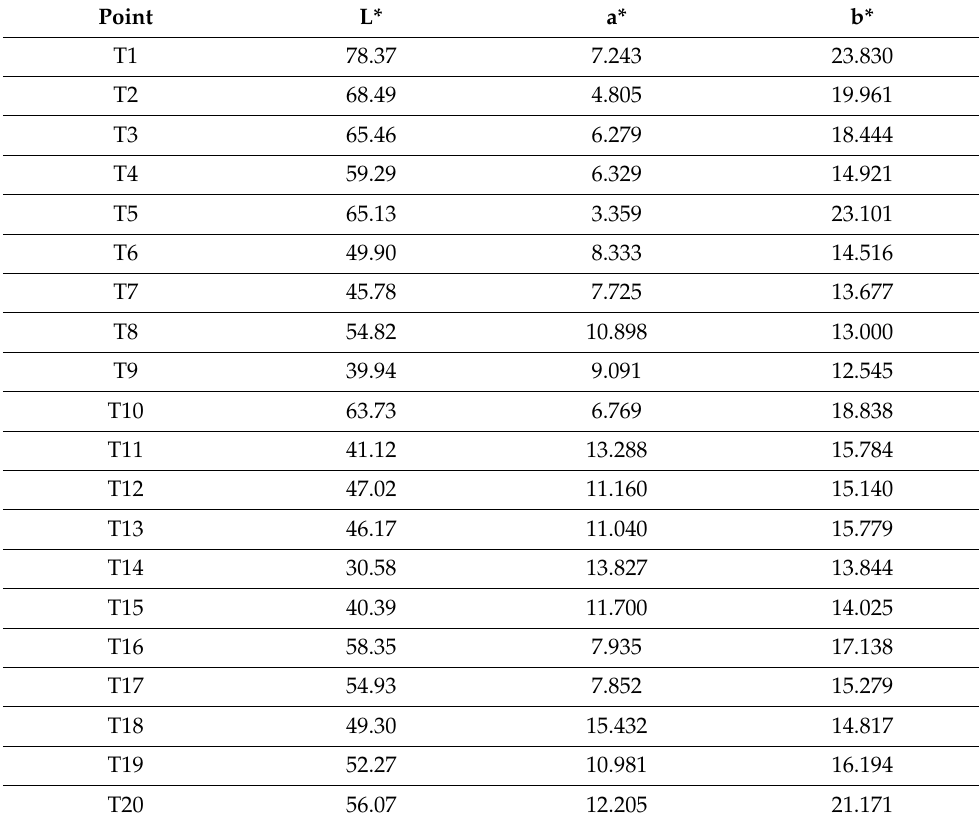
Table 2. The L* a* b*data of the acquired spectra of sample points